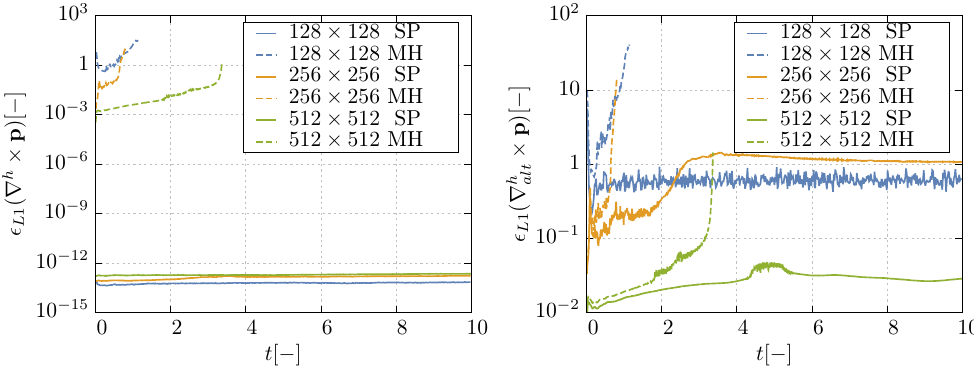
10 − 4 , α = 10 − 2 , β = 10 − 5 , µ = 10 − 2 , c s = 10. The × [ 0.25,0.25 ] 0.25,0.25 ] − × −